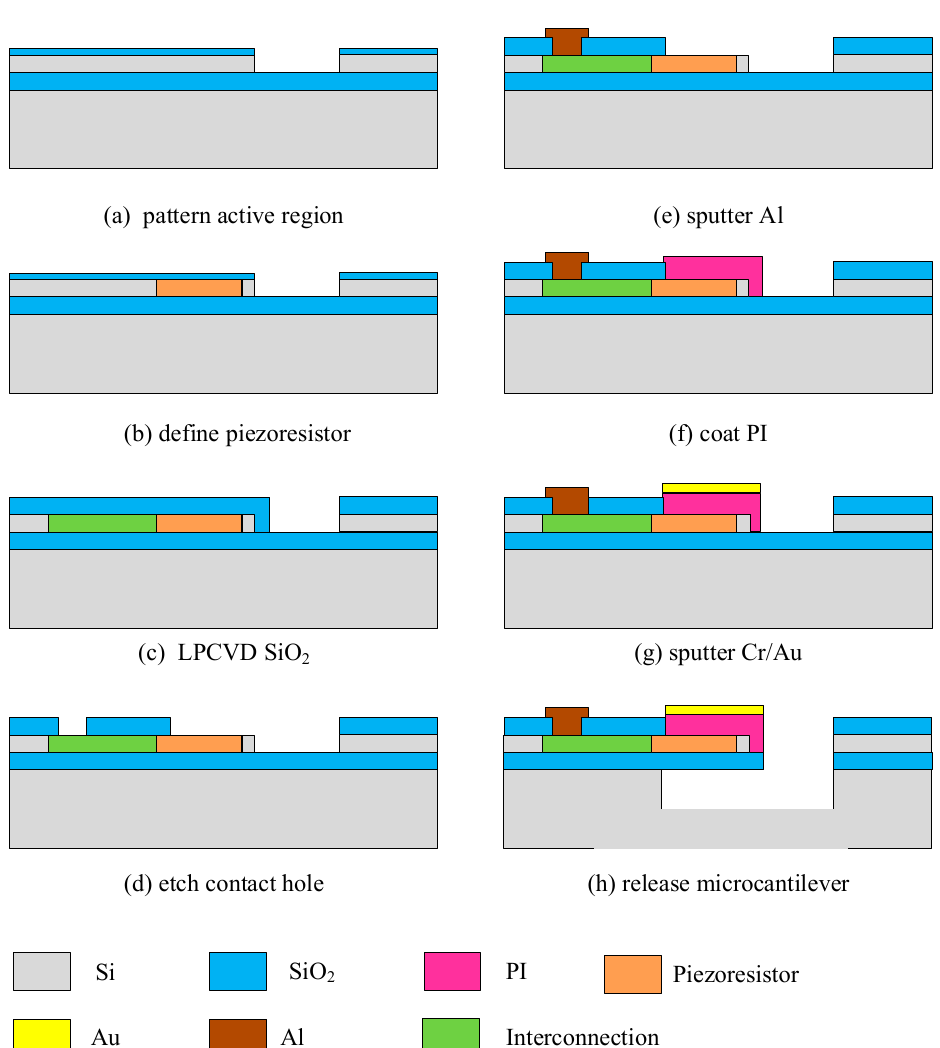
Figure 2. The fabrication processes of PI/Si/SiO 2 microcantilevers.